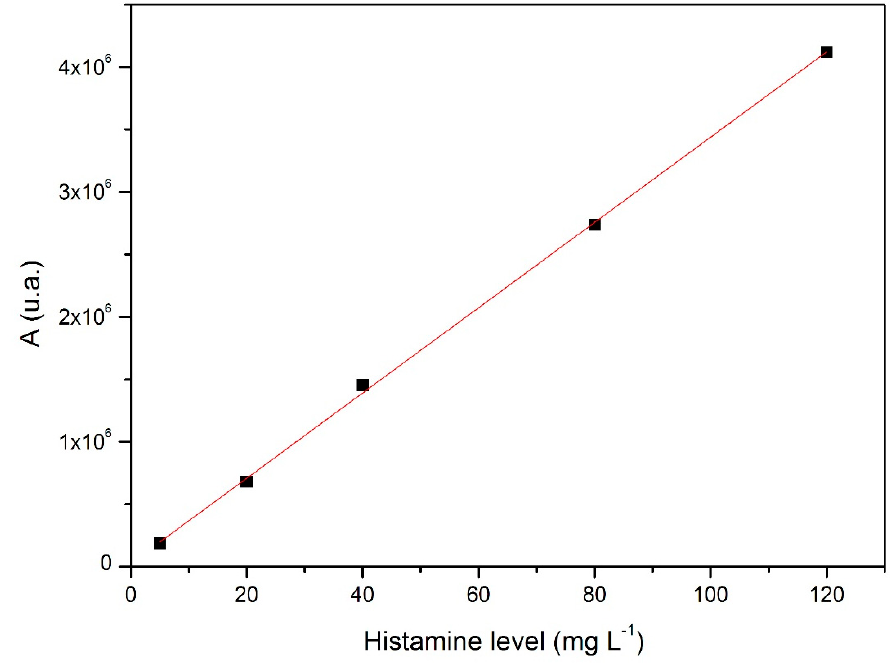
Figure 3. Linearity results of the method proposed for the considered histamine concentration range.